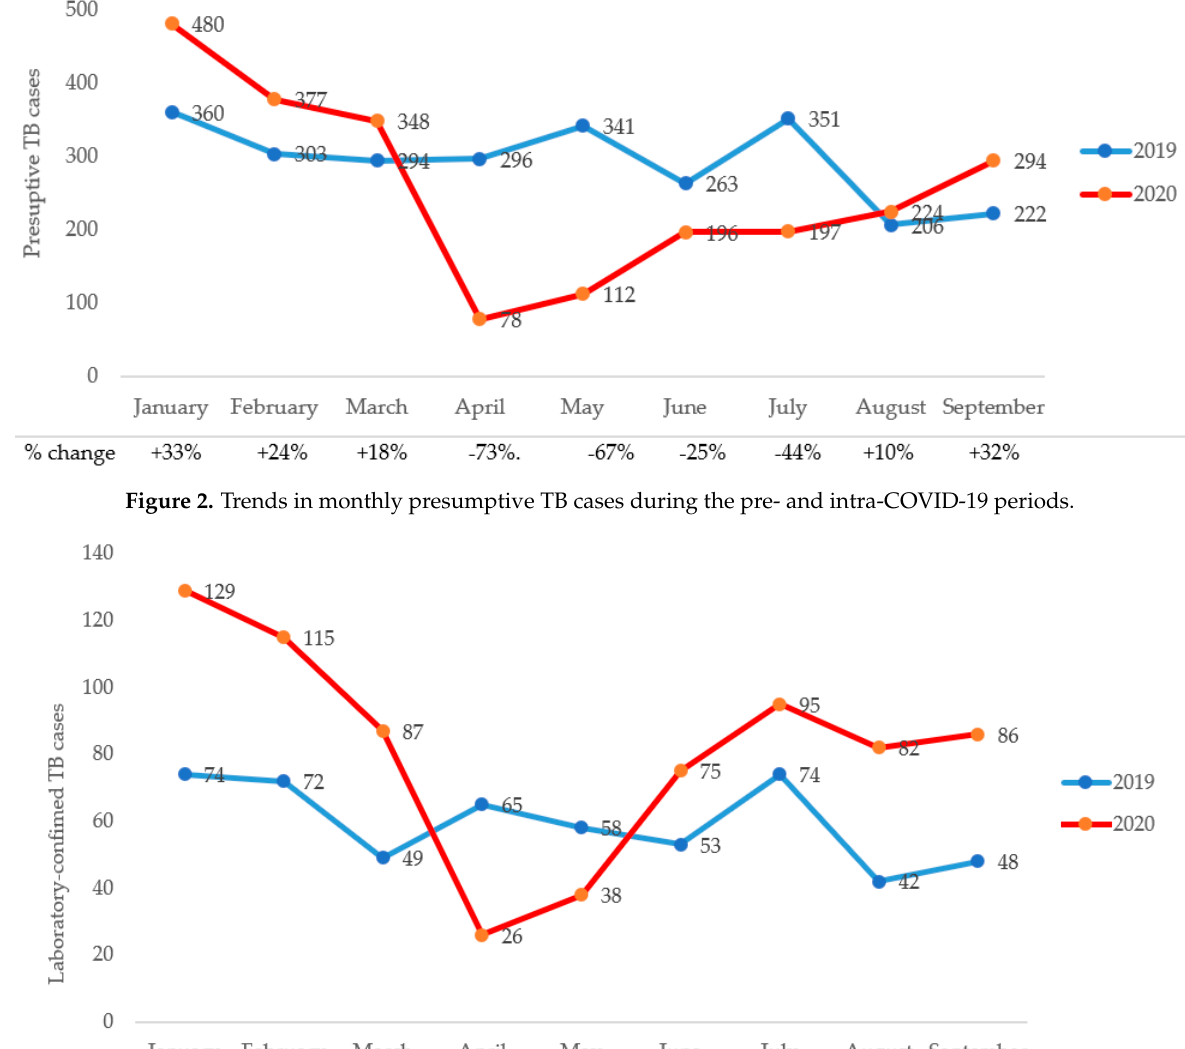
Figure 3. Trends in monthly laboratory-confirmed TB cases during the pre- and intra-COVID-19 periods.